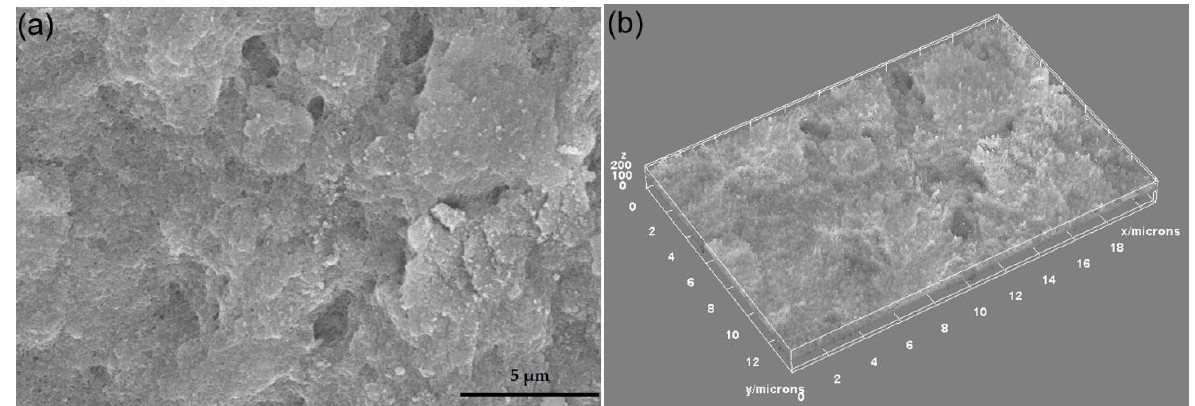
Figure 4. SEM image of DIO-NPs layers at 10,000X magnification ( a ) and 3D surface plot of SEM image of DIO-NPs layers at 10,000X magnification ( b ).